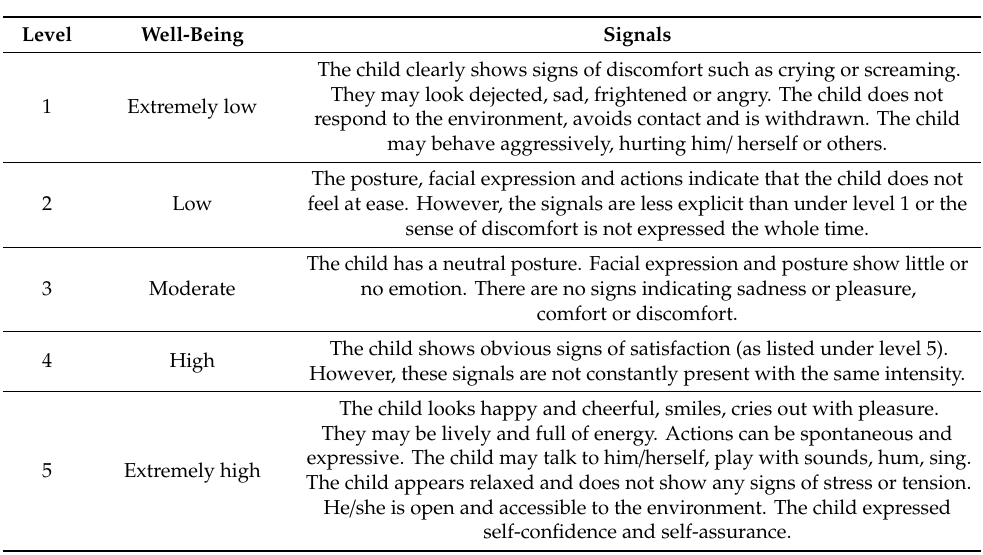
Table 1. The Leuven Scale for Involvement and